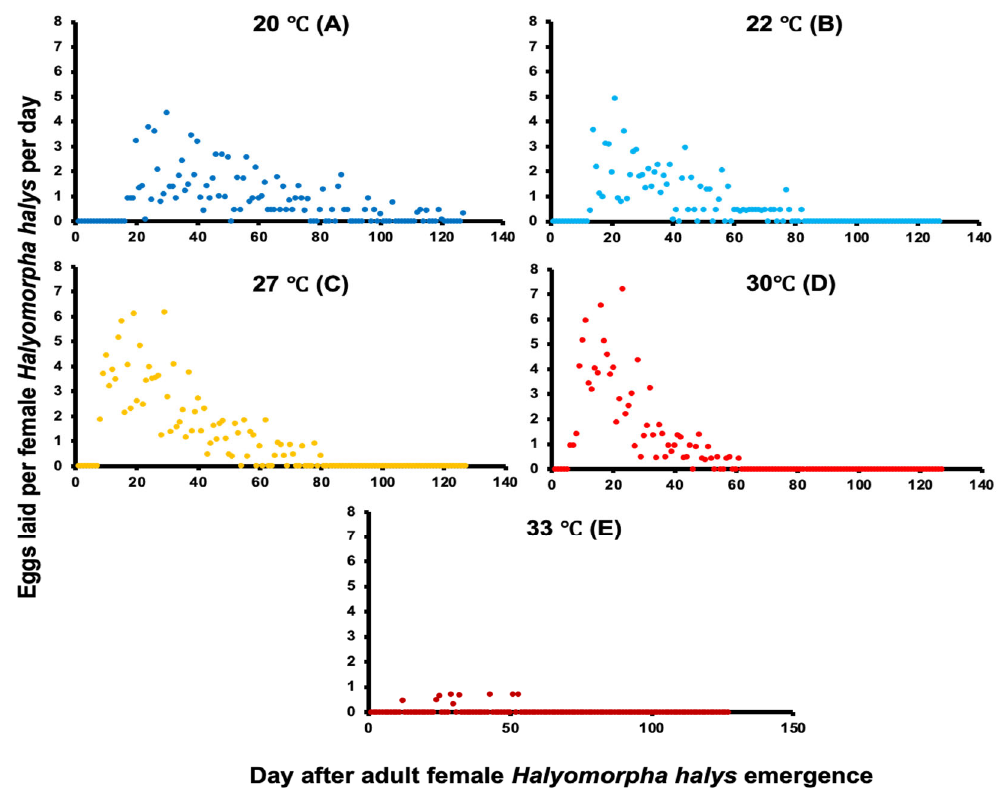
Figure 3. Mean eggs per female per day (EFD) of H. halys in New Jersey at five constant tempera ‐ tures: 20 °C ( A; dark blue), 22 °C ( B; light blue), 27 °C ( C; yellow), 30 °C ( D; red), and 33 °C ( E; dark